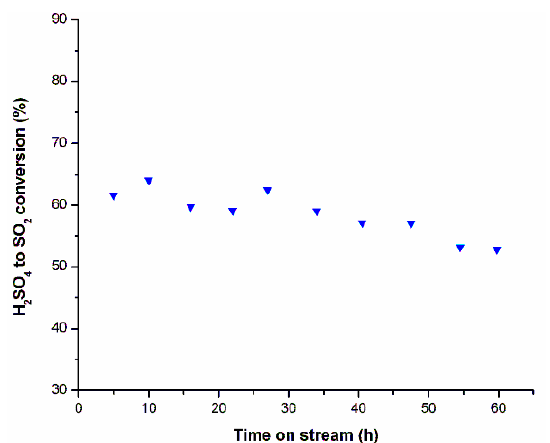
5 hour time on stream.